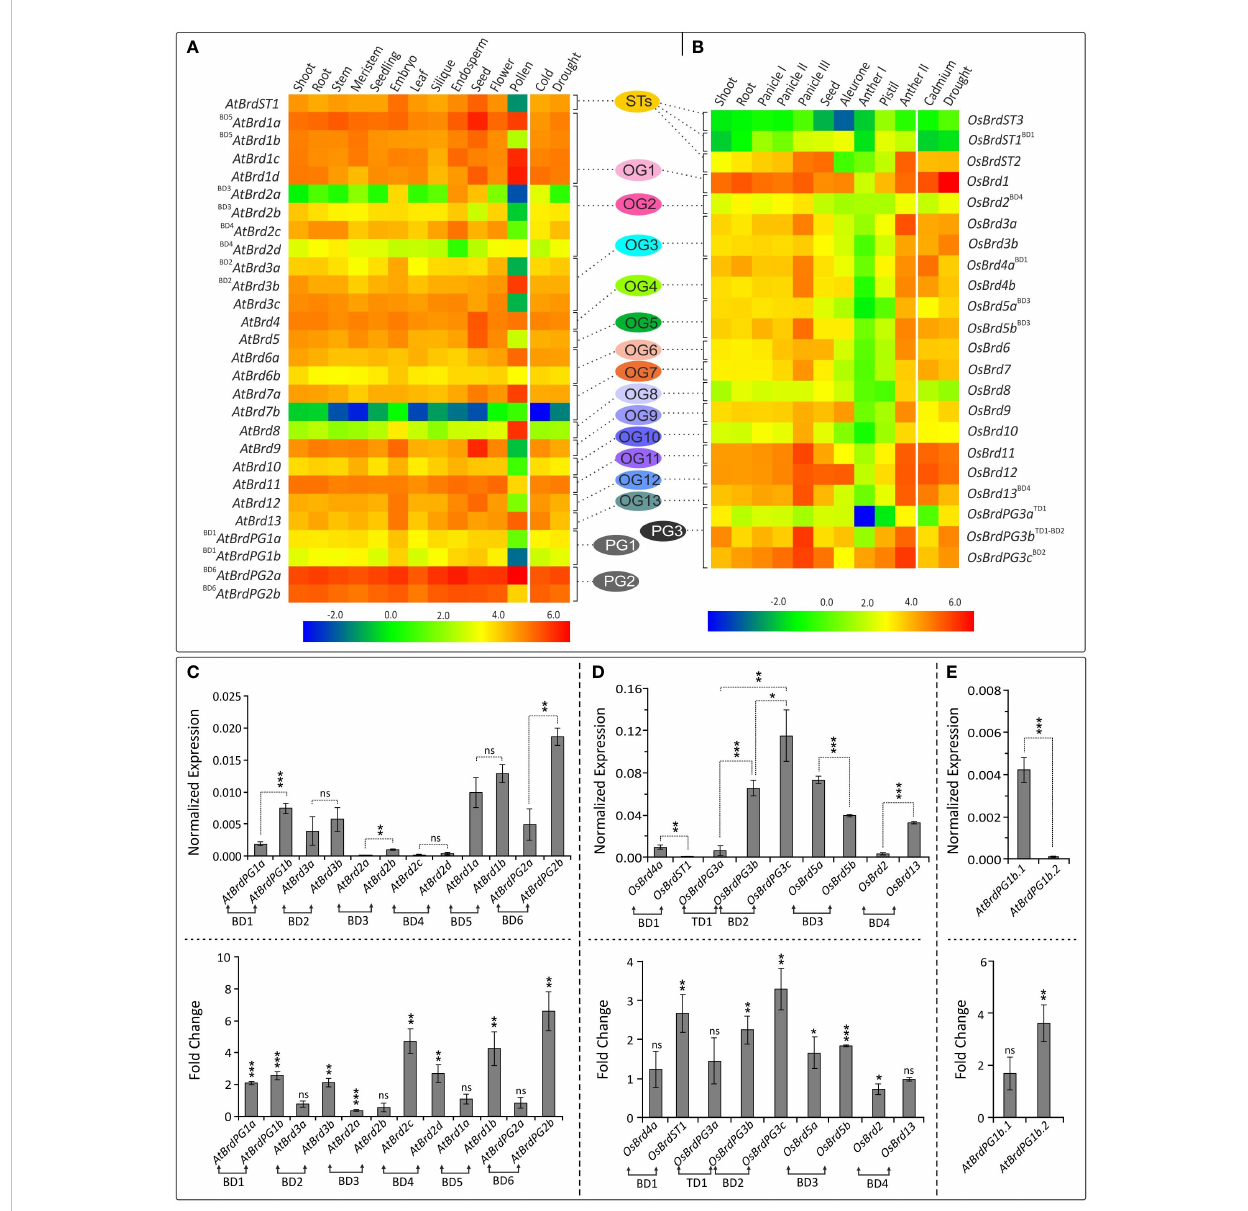
FIGURE 7 Expression analysis of Brd -genes: Heatmap-based analysis of RNA-Seq data for tissue-speci fi c and abiotic stress-responsive expression pattern of Brd -genes of A. thaliana (A) and O. sativa (B) , belonging to thirteen ortholog groups (OG1-13), three paralog groups (PG1-3), and singleton category (STs). Different tissues and stress conditions are indicated on the top, and names of Brd -genes are shown on the sides, with designations ‘ BD ’ and ‘ TD ’ indicating block or tandem duplication event. A continuous color gradient scale is indicative of the expression level (blue: low levels; red: high). RT-qPCR analysis of transcript levels of six duplicated AtBrd -gene pairs (C) and fi ve OsBrd -gene pairs (D) in seedling tissues (top panels), and in response to salt stress (NaCl, 150 mM, bottom panels), using reference genes ( AtActin ; OselF1 a ). Designations ‘ BD ’ and ‘ TD ’ indicate block or tandem duplication event. (E) Expression pattern of two isoforms of AtBrdPG1b (constitutive:.1; alternative:.2) in Arabidopsis seedlings (top panel), and in response to salt stress (bottom panel). The analysis was carried out in triplicate, data is represented as mean ± SD, and statistical signi fi cance is indicated by *( p < 0.05), **( p < 0.01), ***( p < 0.001), ns (no signi fi cant